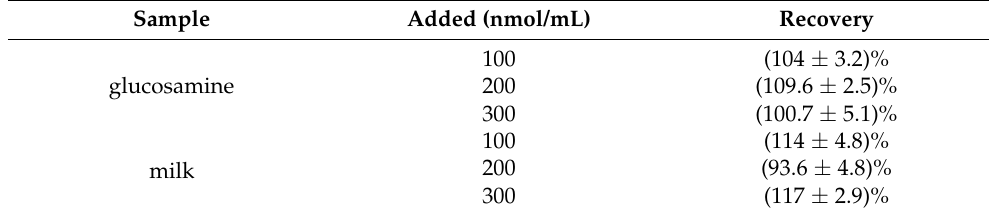
Table 1. Spike recovery results for DEX.